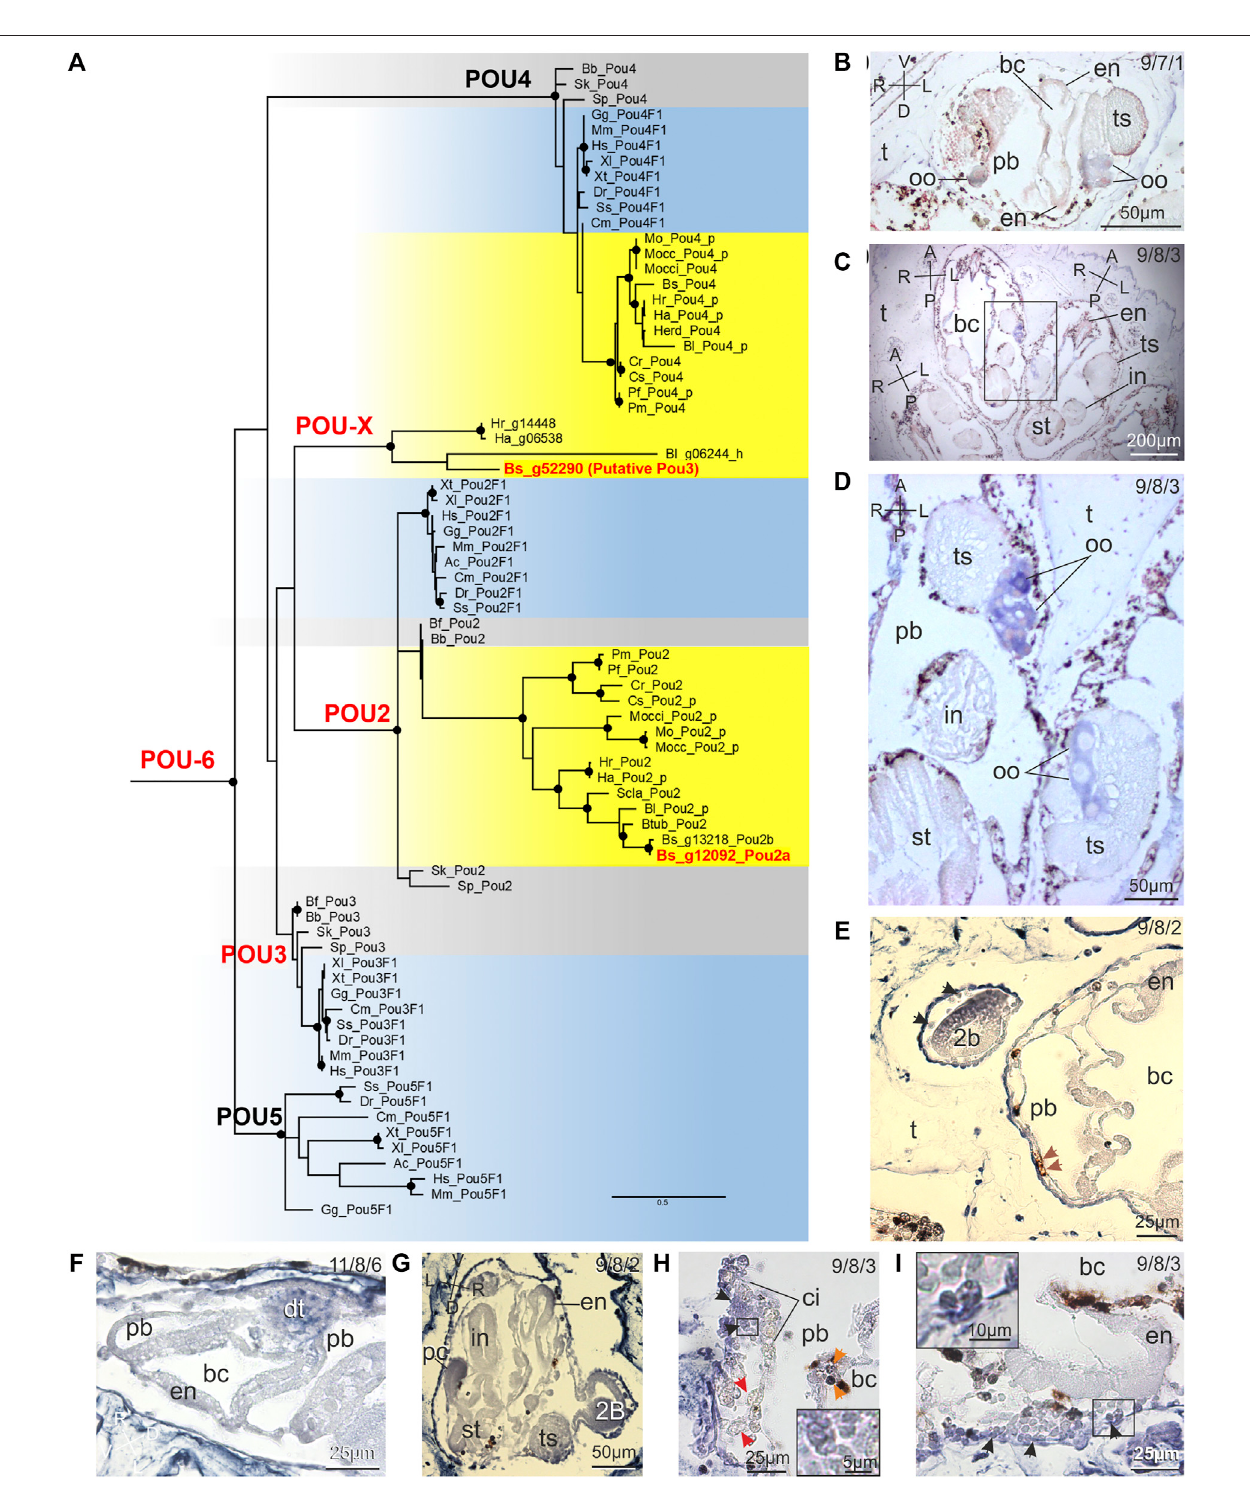
FIGURE4| Pouevolutionandexpressionpatternof Pou2 and Pou3 in B.schlosseri . (A) MLevolutionarytreeofthePOUfamilybasedontheC-terminalregion(199 amino acid sites; best- fi t substitution model JTT+I+G; bootstrap on 100 replicates; Pou6 used as outgroup). The cladogram of the full ML tree, containing all bootstrap values and all Pou6 outgroups, isshown in Supplementary Image 1 . Black dots: bootstrap values ≥ 70%; red: B. schlosseri sequences used in ISH; yellow: ascidians; light blue: vertebrates; grey: other deuterostomes. Species abbreviations are as in Figure 2 . Species classi fi cation and sequence data are in Supplementary Table1 andin SupplementaryTable4 ,respectively.Sequenceswiththe “ _p ” suf fi xwereannotated exnovo orre-annotatedinthisstudy;thesequencewith “ _h ” suf fi x